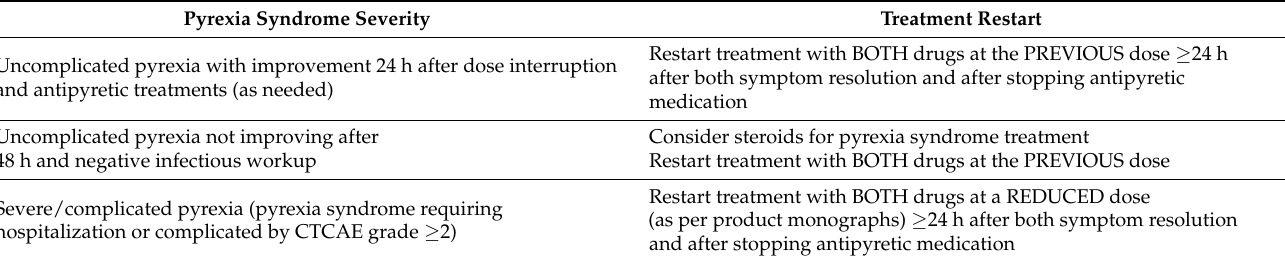
Table 2. Recommendations for restarting treatment after the first occurrence of pyrexia syndrome. Pyrexia Syndrome Severity Treatment